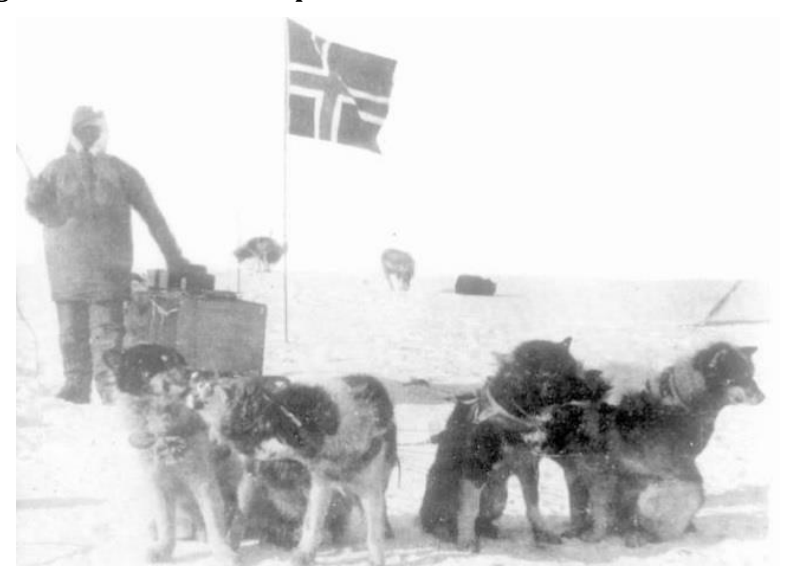
Figure 12: Amundsen’s expedition used TEK to reach the South Pole